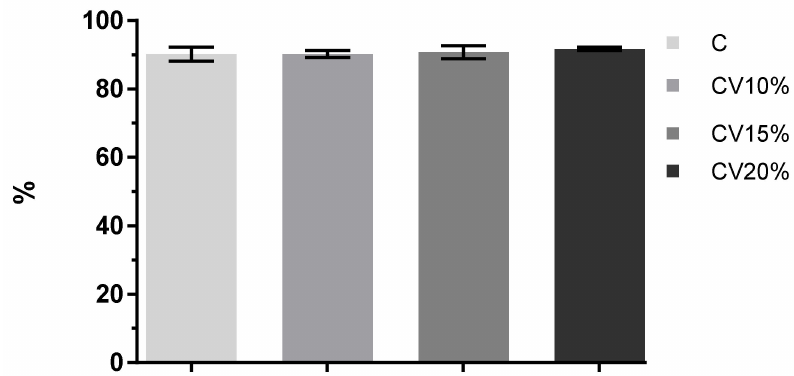
Figure 2. Digestibility of breast muscle of broilers chickens fed different levels of C. vulgaris for 40 days. Data shown are mean ± SE, n = 3.